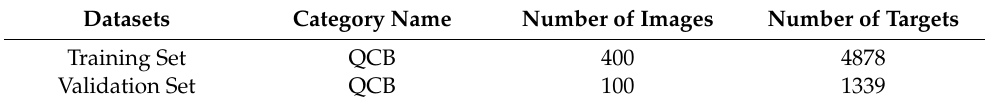
Table 2. Training and test set